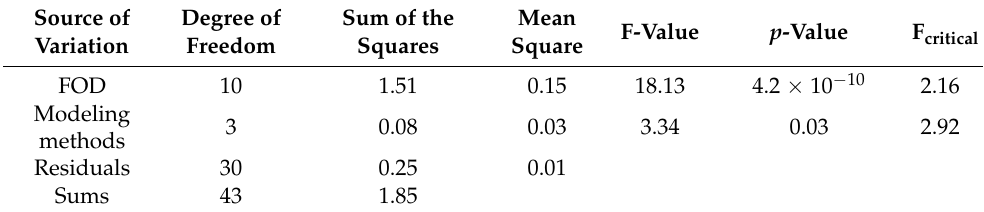
Table 8. Analyses of variance with the RMSE values for Hg. Source of Variation